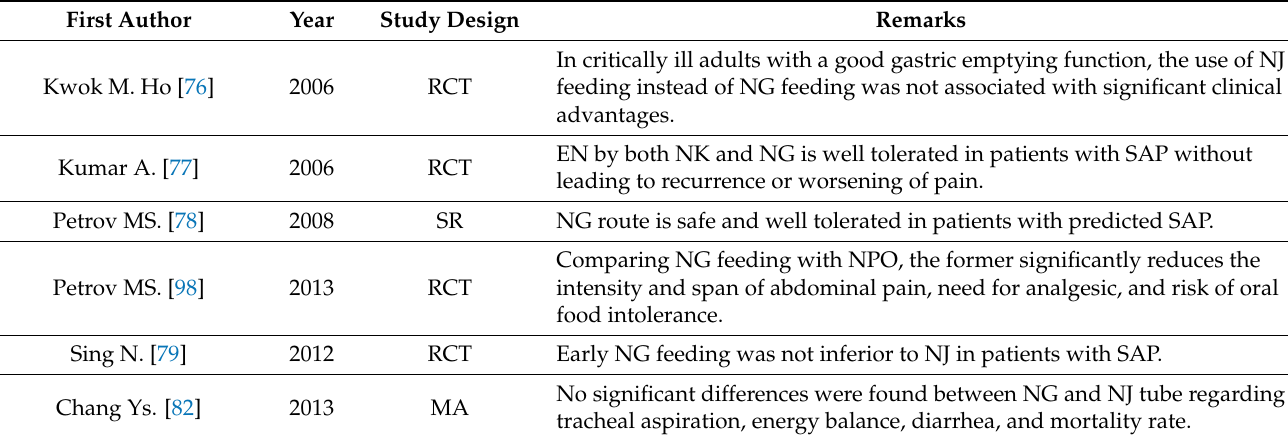
Table 1. Evidence regarding NG feeding in acute